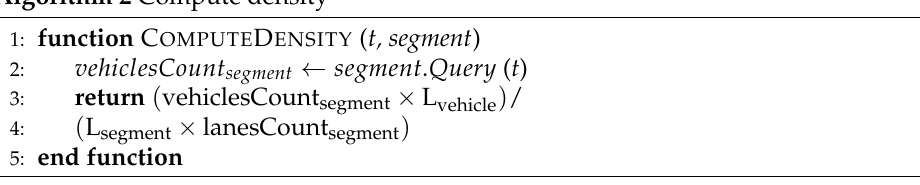
Algorithm 3 Compute